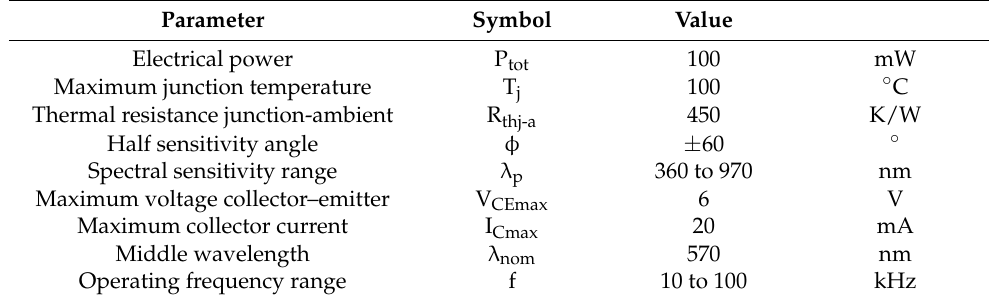
Table 2. Operating parameters of the sensor TEMT6000 [54].